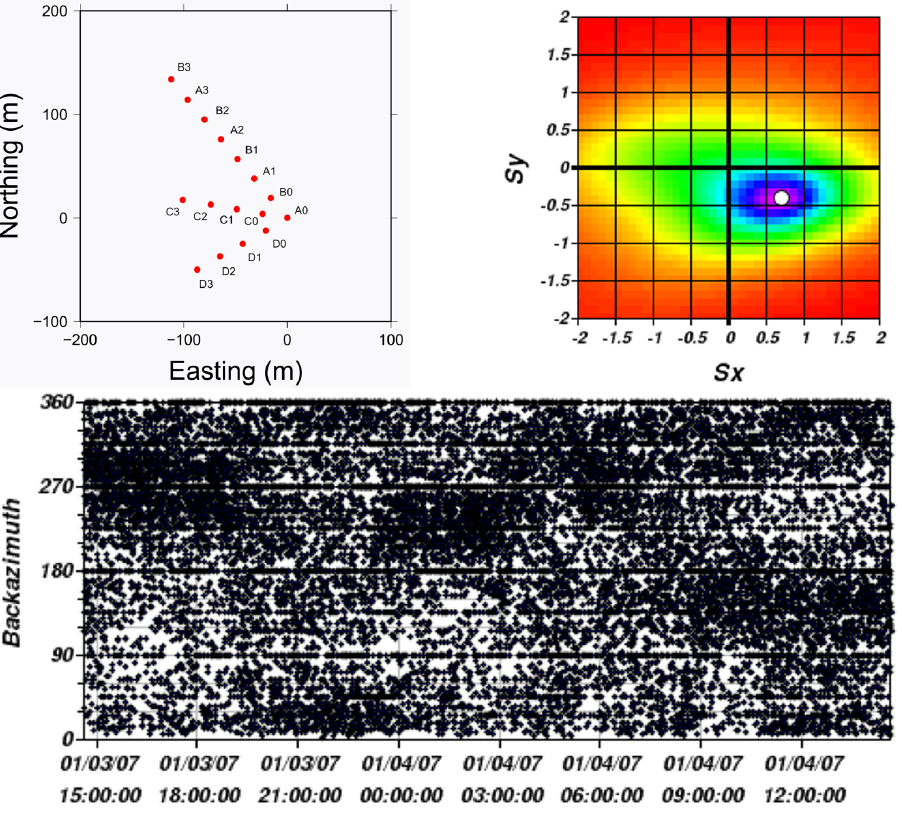
Figure 5. Top left: geometry of the permanent seismic array located in position indicated by the cross in Figure 1. Horizontal and vertical units are meters; labels indicate the array element names. Top right: slowness spectrum of 5 second of signal. Units are in s/km. Bottom: backazimuth analysis for a time window representing a typical